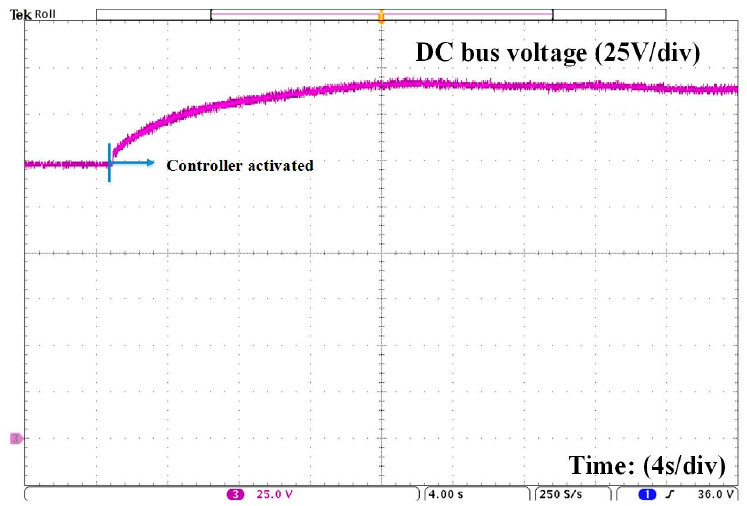
Figure 24. Ignition of the control for the rectifier.